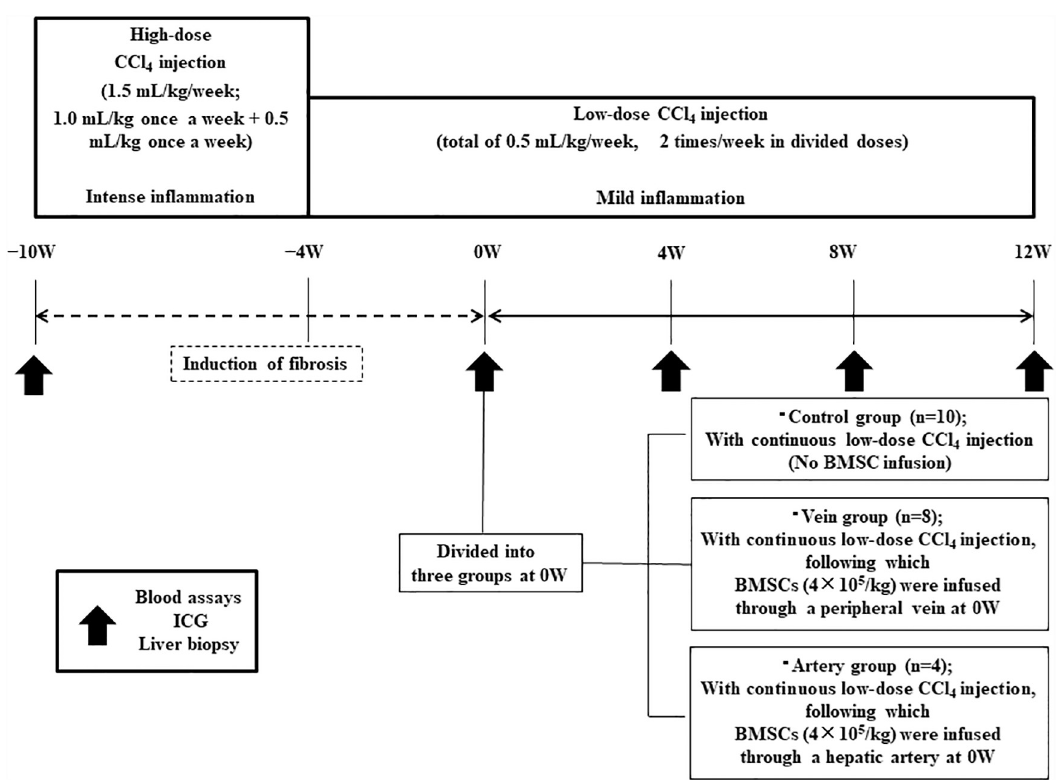
Fig 1. Experimental protocol for canine model of liver fibrosis and treatment. The canines were administered repeated carbon tetrachloride (CCl 4 ) injections through the implanted catheter for 10 weeks (high-dose period: 1.0 mL/kg body weight once per week and 0.5 mL/kg body weight once per week for 6 weeks; low-dose period: 0.25 mL/kg body weight twice per week for 4 weeks). CCl 4 was injected on the first and fourth days of each week. At 0 weeks (0W; i.e. after 10 weeks of CCl 4 injections), the canines were divided into three groups. In the control group, low-dose CCl 4 injection was continued for a further 12 weeks without bone marrow- derived mesenchymal stem cell (BMSC) infusion. In the Vein group, cultured autologous canine BMSCs (4 × 10 5 /kg) were infused through a peripheral vein, and low-dose CCl 4 injections were continued for 12 more weeks. In the Artery group, cultured autologous BMSCs (4 × 10 5 /kg) were infused through a hepatic artery using angiography, and low-dose CCl 4 injections were continued for 12 more weeks. In all three groups, blood assays, indocyanine green (ICG) testing, and liver biopsy based on ultrasonography were performed at − 10W, 0W, 4W, 8W, and 12W, as indicated by the